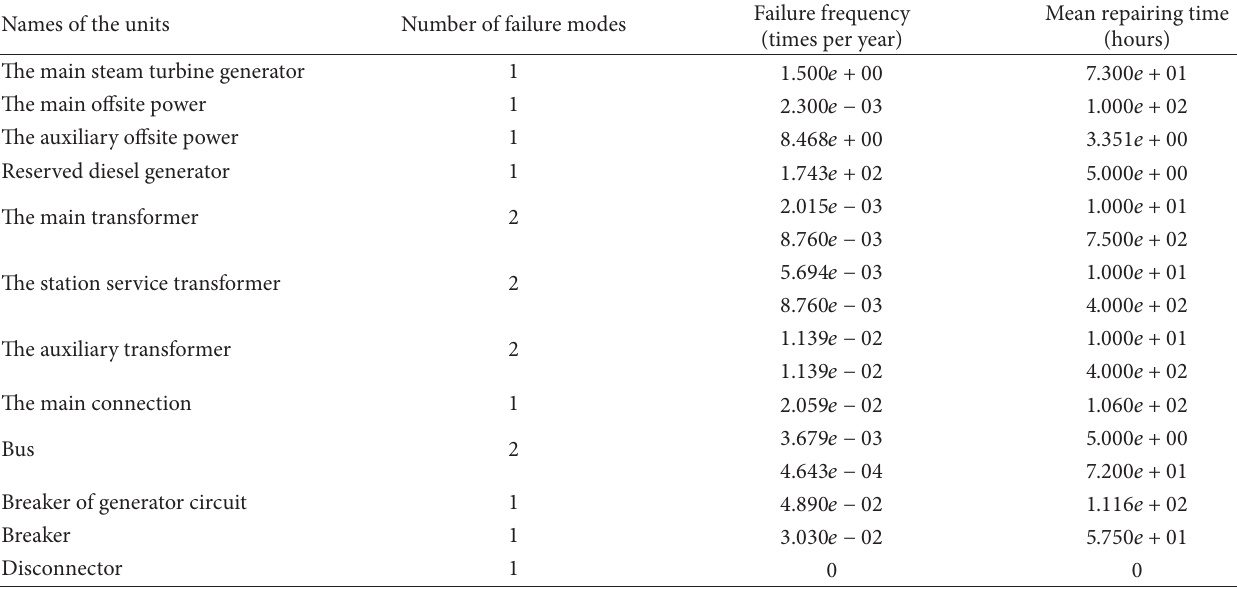
Table 2: The failure frequency and mean repairing time of repairable components.